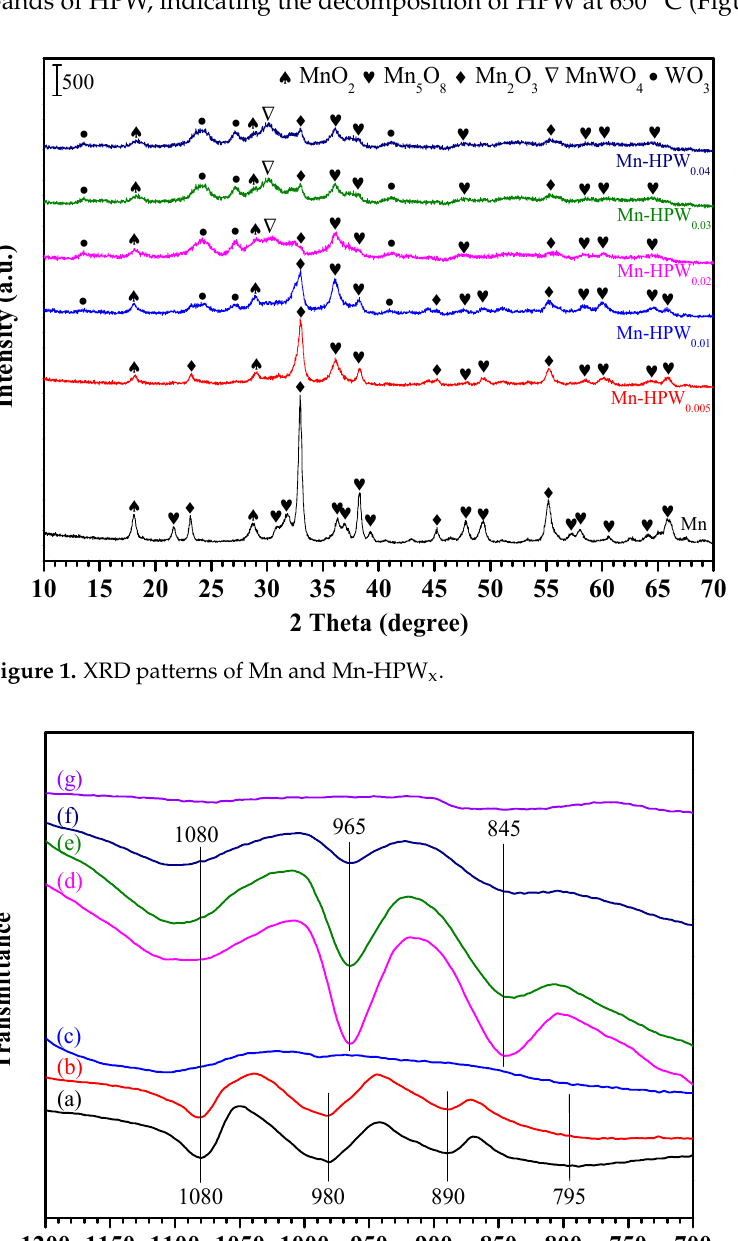
Figure 1. XRD patterns of Mn and Mn-HPW x .